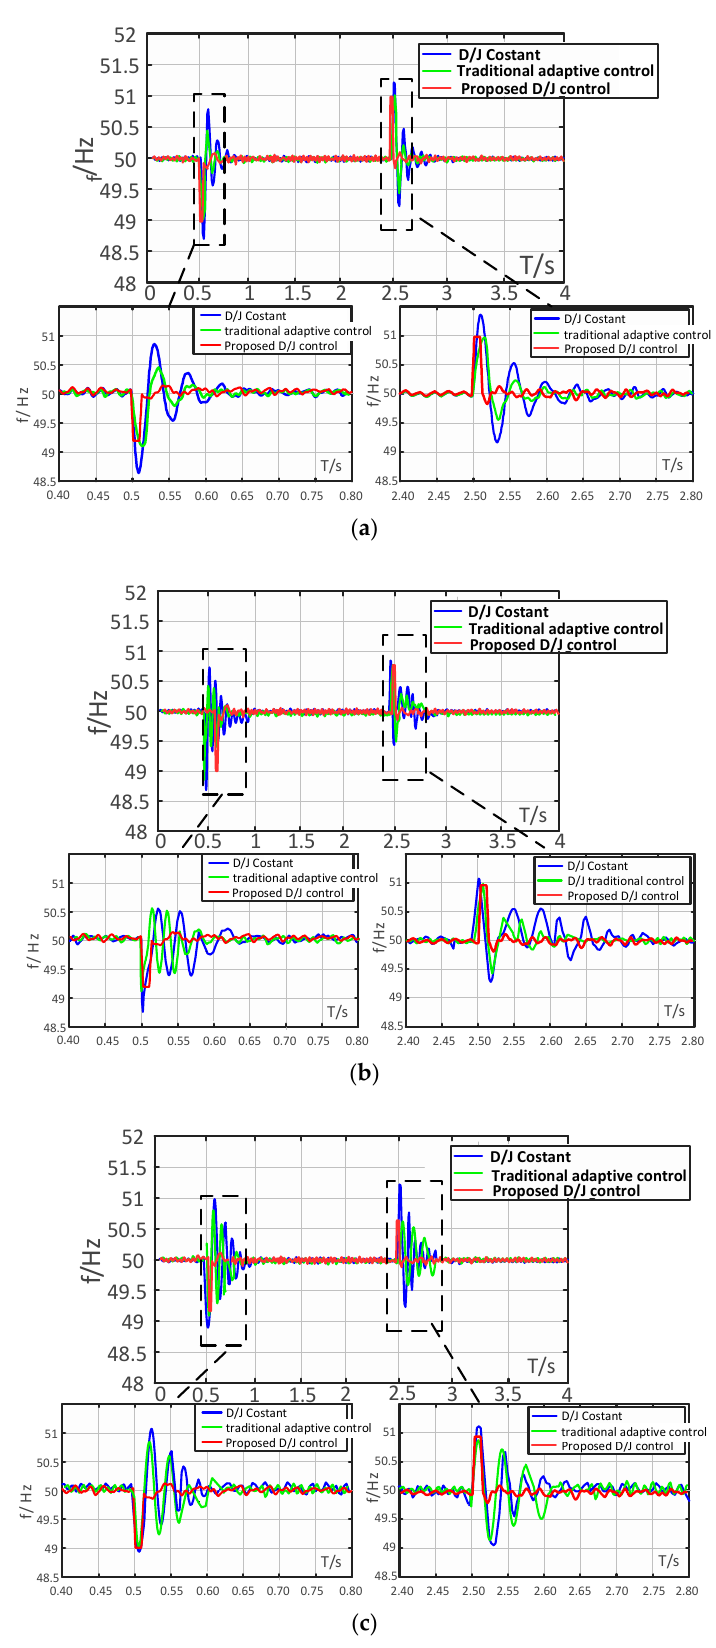
Figure 12. Frequency response among different controllers: ( a ) VSG1; ( b ) VSG2; ( c ) VSG3.